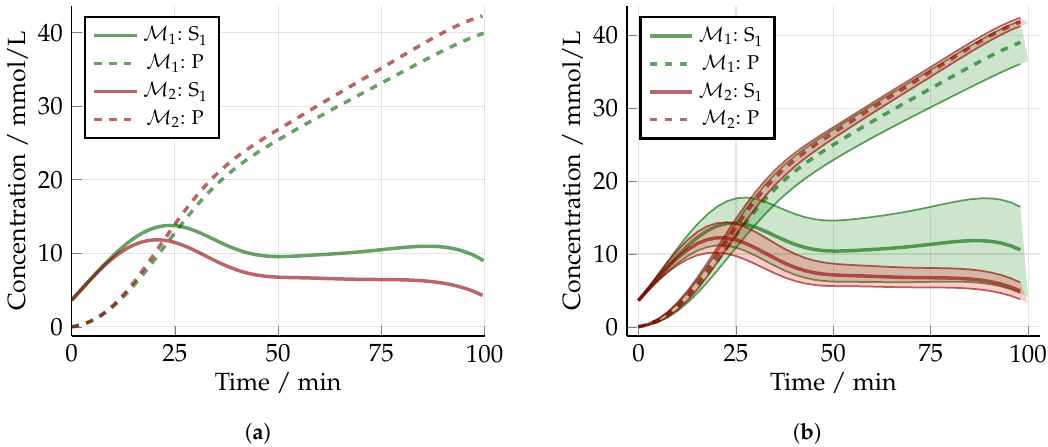
Figure 8. Measured states for the robust flatness-based design. ( a ) Output trajectories neglecting parameter uncertainties; ( b ) Confidence intervals due to parameter uncertainties. Table 4. Results for the overlap.